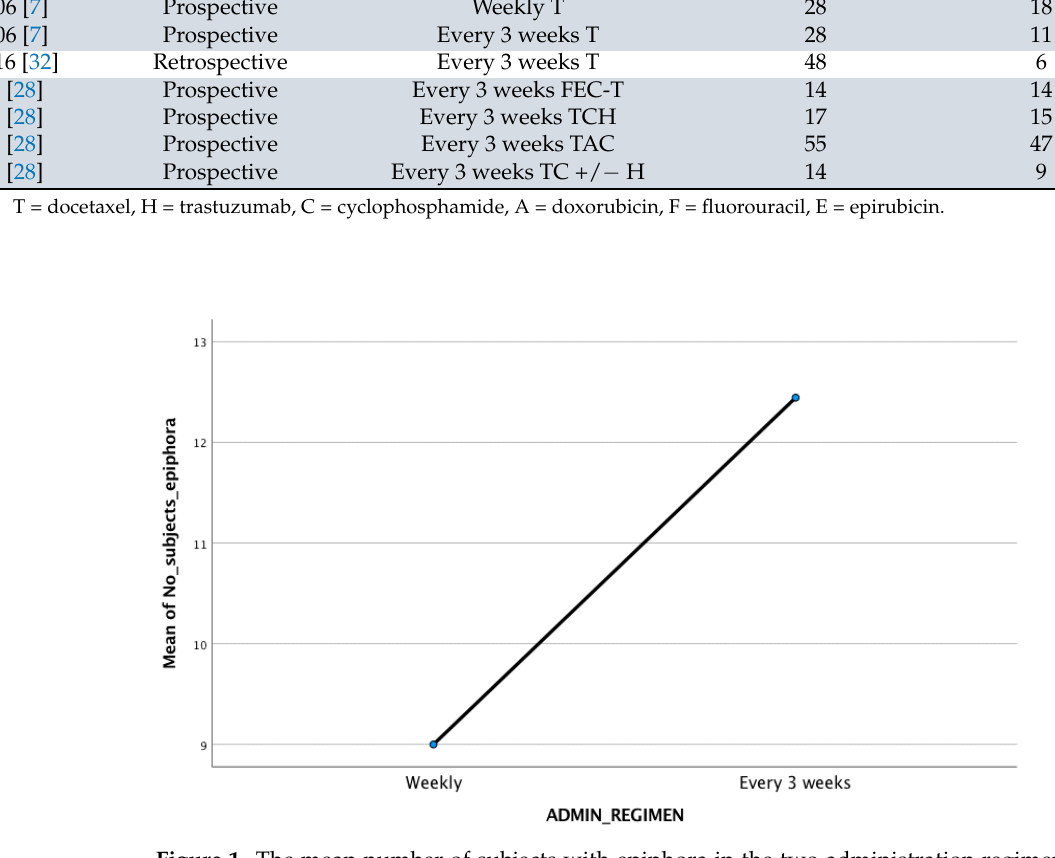
Figure 1. The mean number of subjects with epiphora in the two administration regimens (9 for weekly administration, 12.4 for every 3 weeks regimen). Themeandoseintensityforpatientstreatedbyweeklyadministrationwas33.36 mg/m 2 /week (SD = 2.53). The mean dose intensity for patients treated by every 3 weeks administration was 26.11 mg/m 2 /week (SD = 4.37). The difference between dose intensity for the thera- peutic regimen is statistically significant ( p < 0.0001), and there is a negative correlation between the dose intensity value and the number of weeks between doses. The median for dose intensity independent of the treatment regimen was 30 mg/m 2 /week, and the incidence of the epiphora was similar (not statistically significant different) for doses over and under this value (Figures 3 and